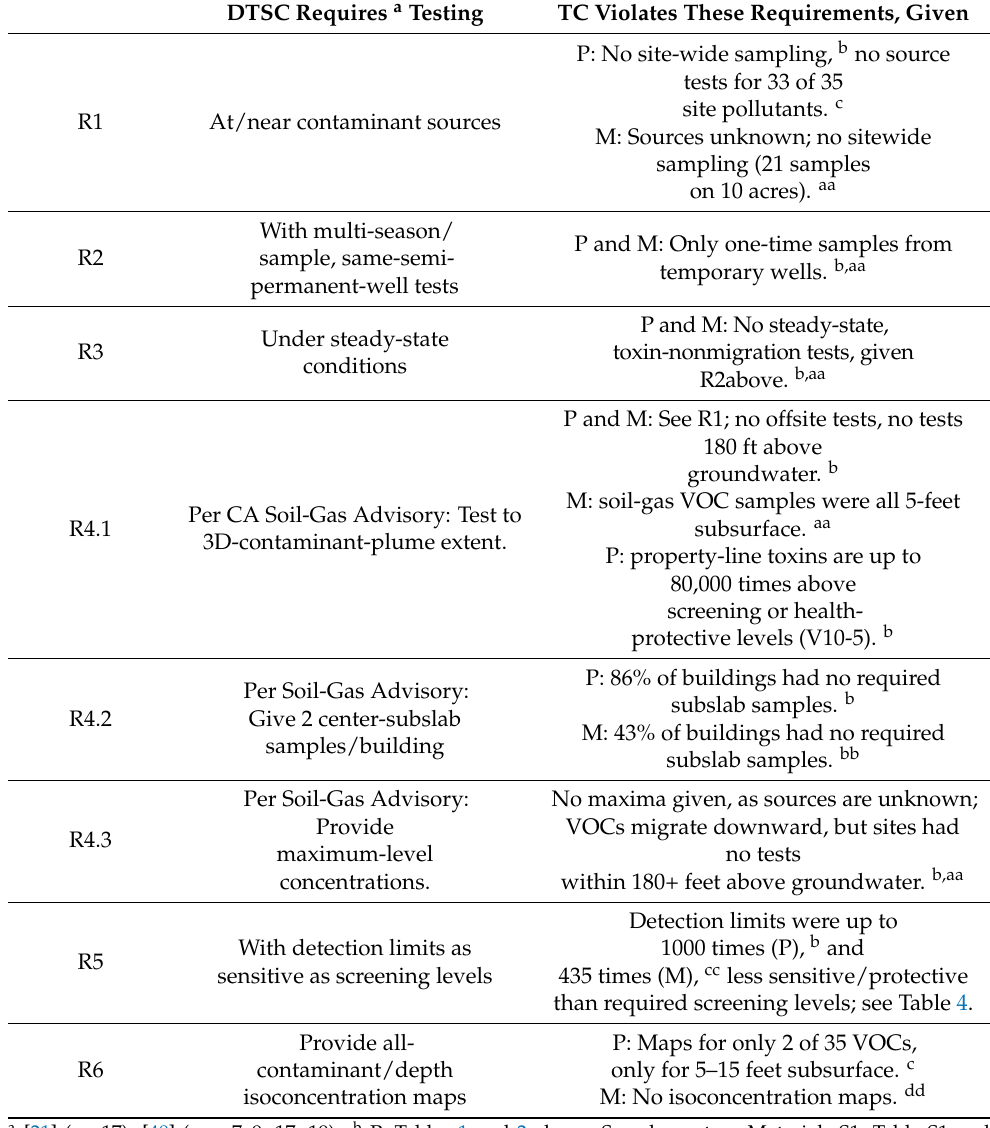
Figure S2. c P: Supplementary Materials S1, (Figures S3–S6). aa M: [62] (Table 1). bb M: Supplementary Materials S1 (Figure S13). cc M: [62]. dd M: